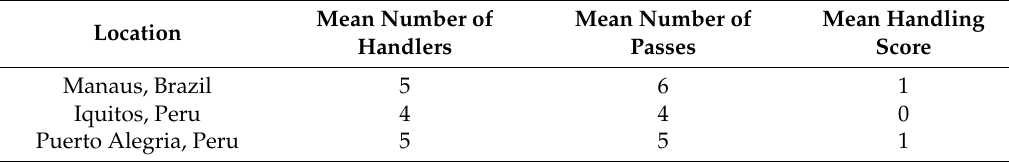
Table 4. Mean number of handlers and handling score for each tourist site. Location